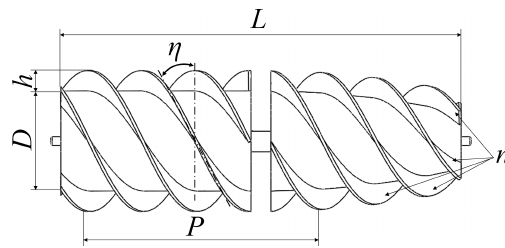
Figure 3. Schematic diagram of the single screw structure.